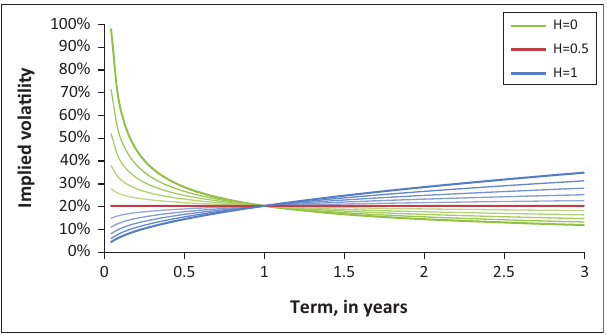
FIGURE 1: Possible implied volatility term structures in a fractional Black– Scholes market for different Hurst exponents and σ